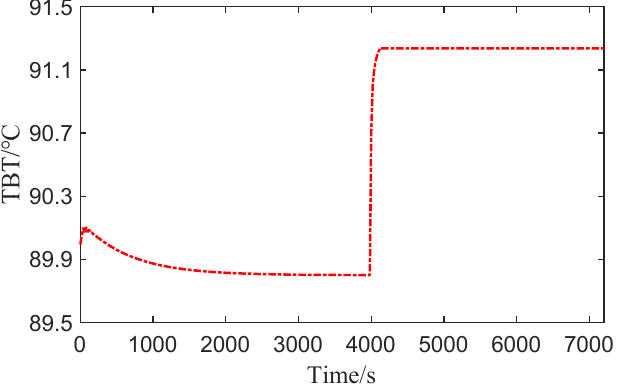
Figure 28. Dynamic of TBT for step increase in T steam .